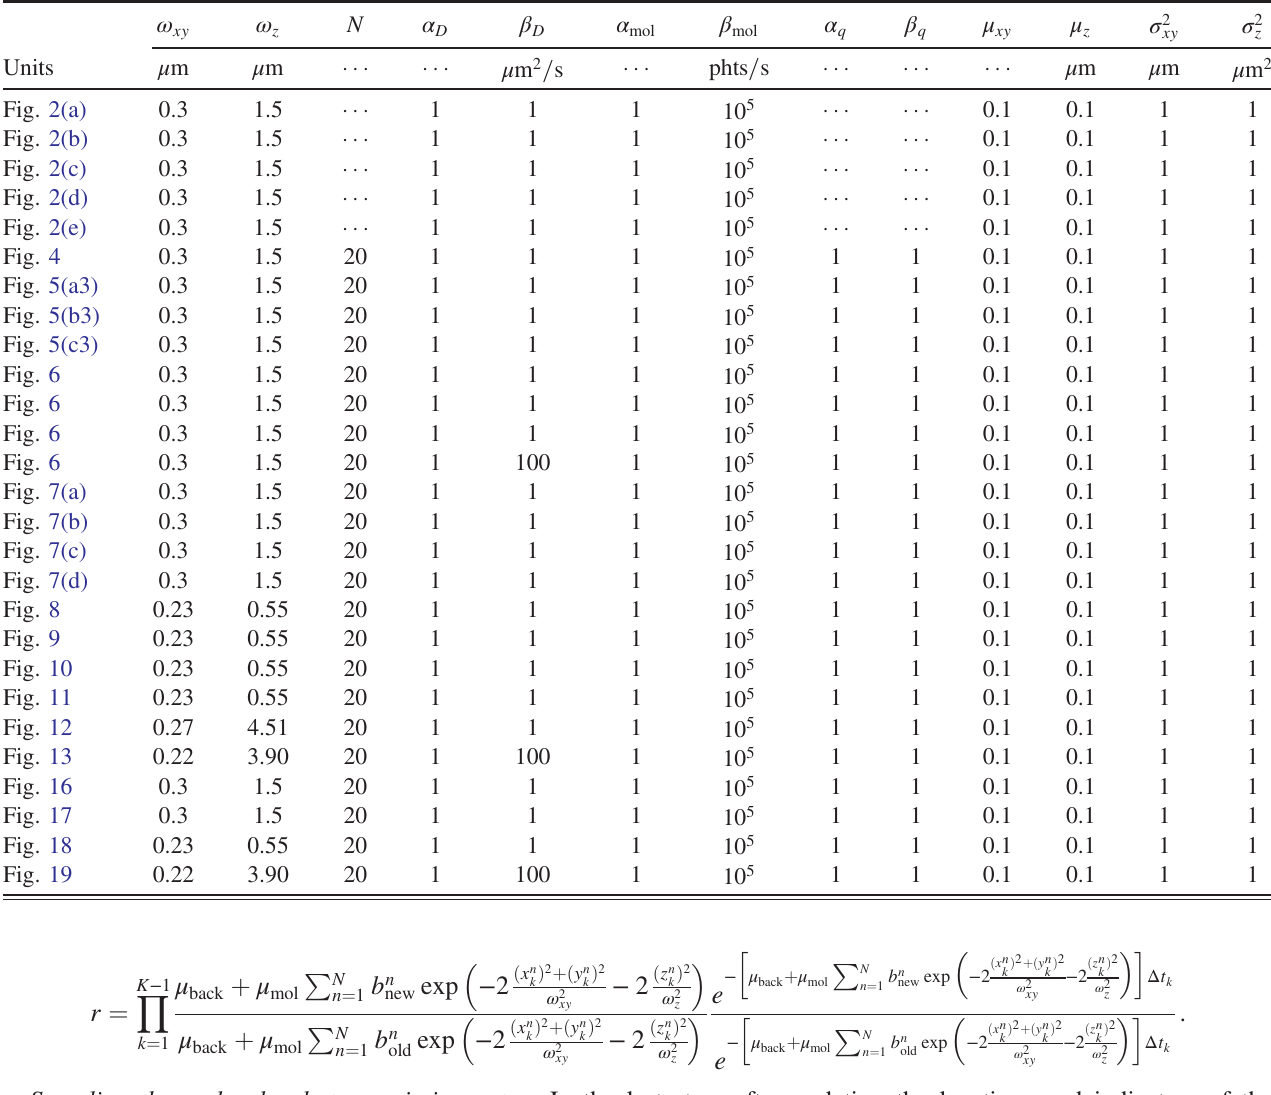
TABLE V. Parameter values used in the analyses of the traces. Choices are listed according to figures. ω